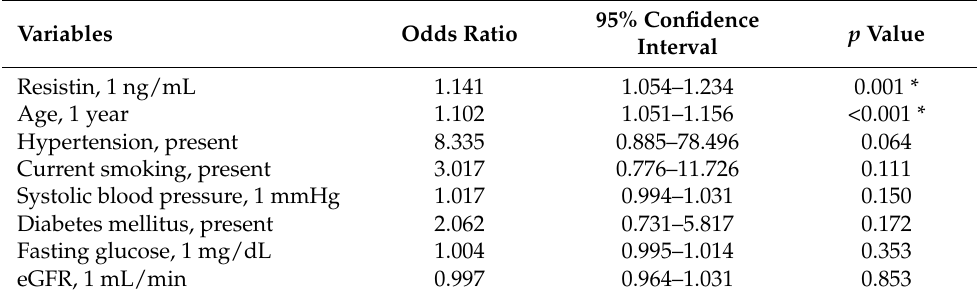
Table 2. Multivariate logistic regression analysis of the factors correlated to peripheral arterial disease among 240 chronic kidney disease